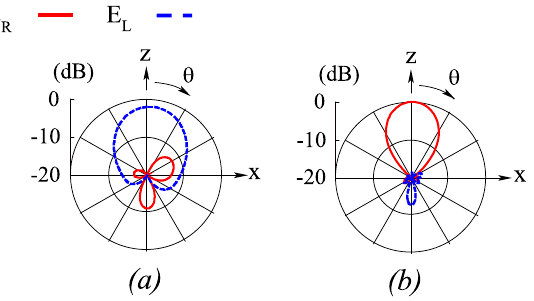
Fig. 11. Normalized radiation patterns for the round metaloop-C antenna when gains G L and G R are maximal. (a) At f GLmax = 2.70GHz. (b) At f